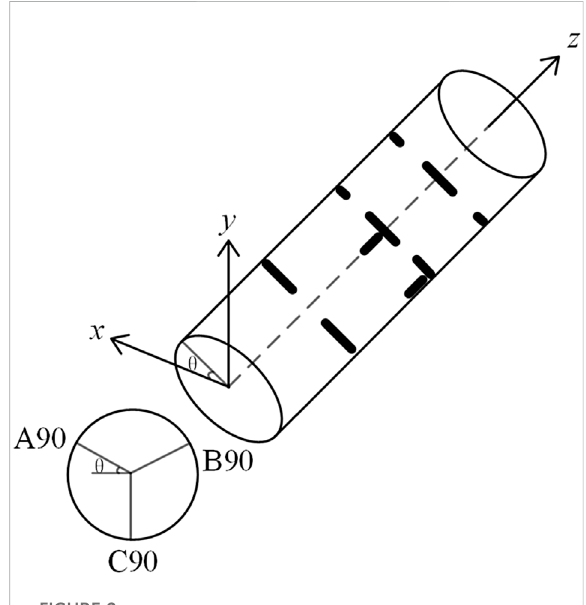
FIGURE 2 Layout scheme of strain gauges for stress monitoring in a slope rock